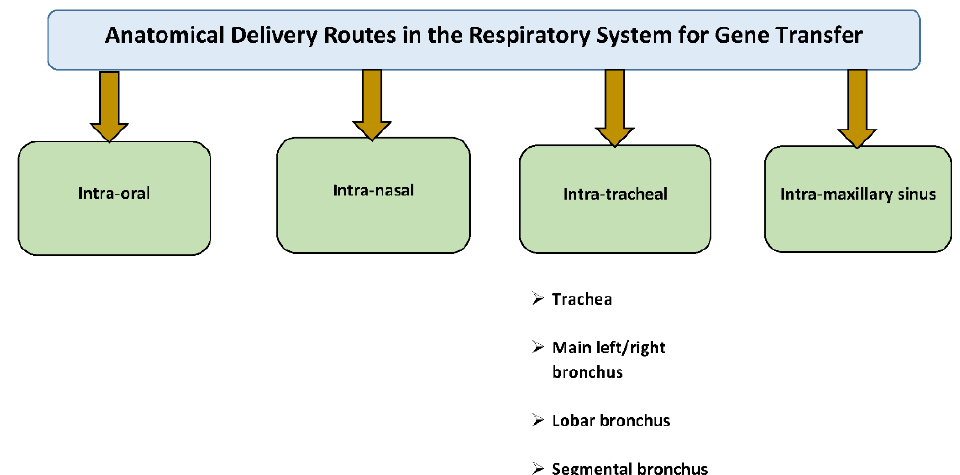
Figure 2. Anatomical delivery routes in the respiratory system for gene transfer.